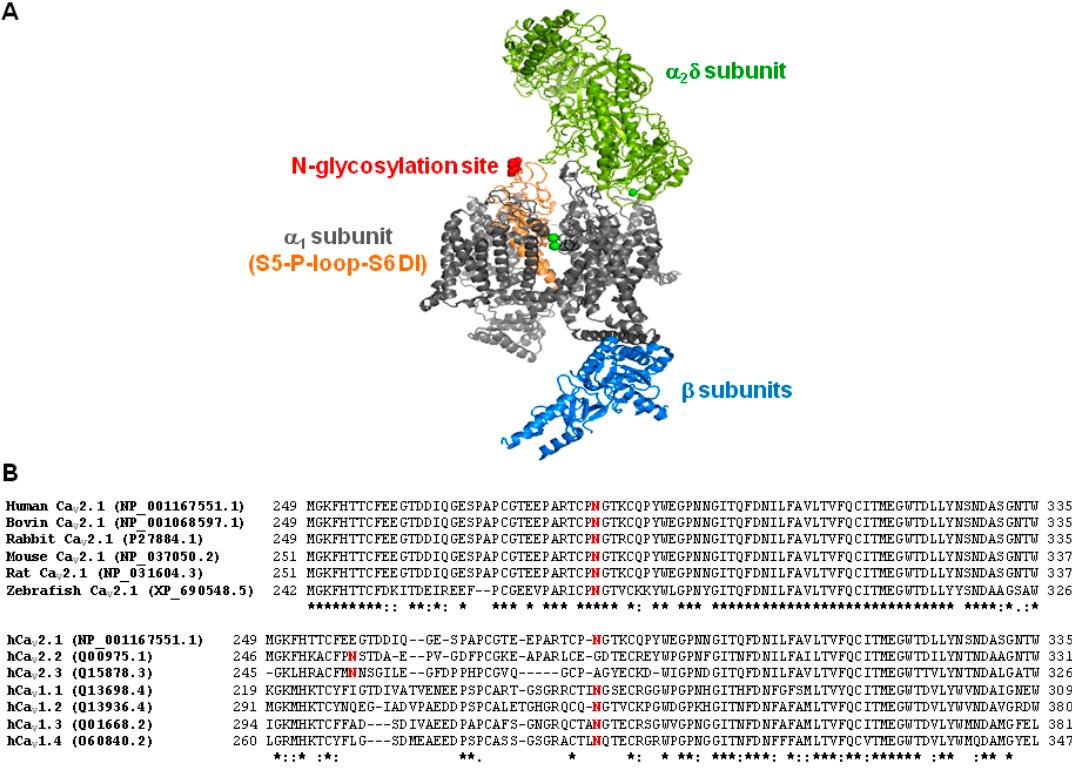
Figure 6. Location and conservation of the N283 amino acid residue. ( A ) Illustration showing the location of the potential glycosylation site at residue N283 (in red) at the extracellular P-loop between S5 and S6 transmembrane segments in domain I of the pore forming α 1A subunit (in orange). The structure of the Ca V 1.1 complex, containing α 1 (in grey), β (in blue) and α 2 δ (in green) subunits, was used as model (PDB 5GJV). ( B ) Sequence alignment of P-loop regions at domain I (DI) of Ca V 2.1 channel α 1A subunits from different organisms (as indicated) (top), and sequence alignment of P-loop-DI α 1 regions of human high-voltage activated Ca 2+ channels belonging to the Ca V 2.x and Ca V 1.x families (bottom). Alignments were performed with Clustal Omega (www.ebi.ac.uk/Tools/msa/clustalo/, access on 30 November 2017). Potential sites for N -glycosylation (including N283 at the human Ca V 2.1 channel) are shown in red. Asterisk means identical residues; colon and period indicates the existence of conservative and semi-conservative amino acid substitutions, respectively.